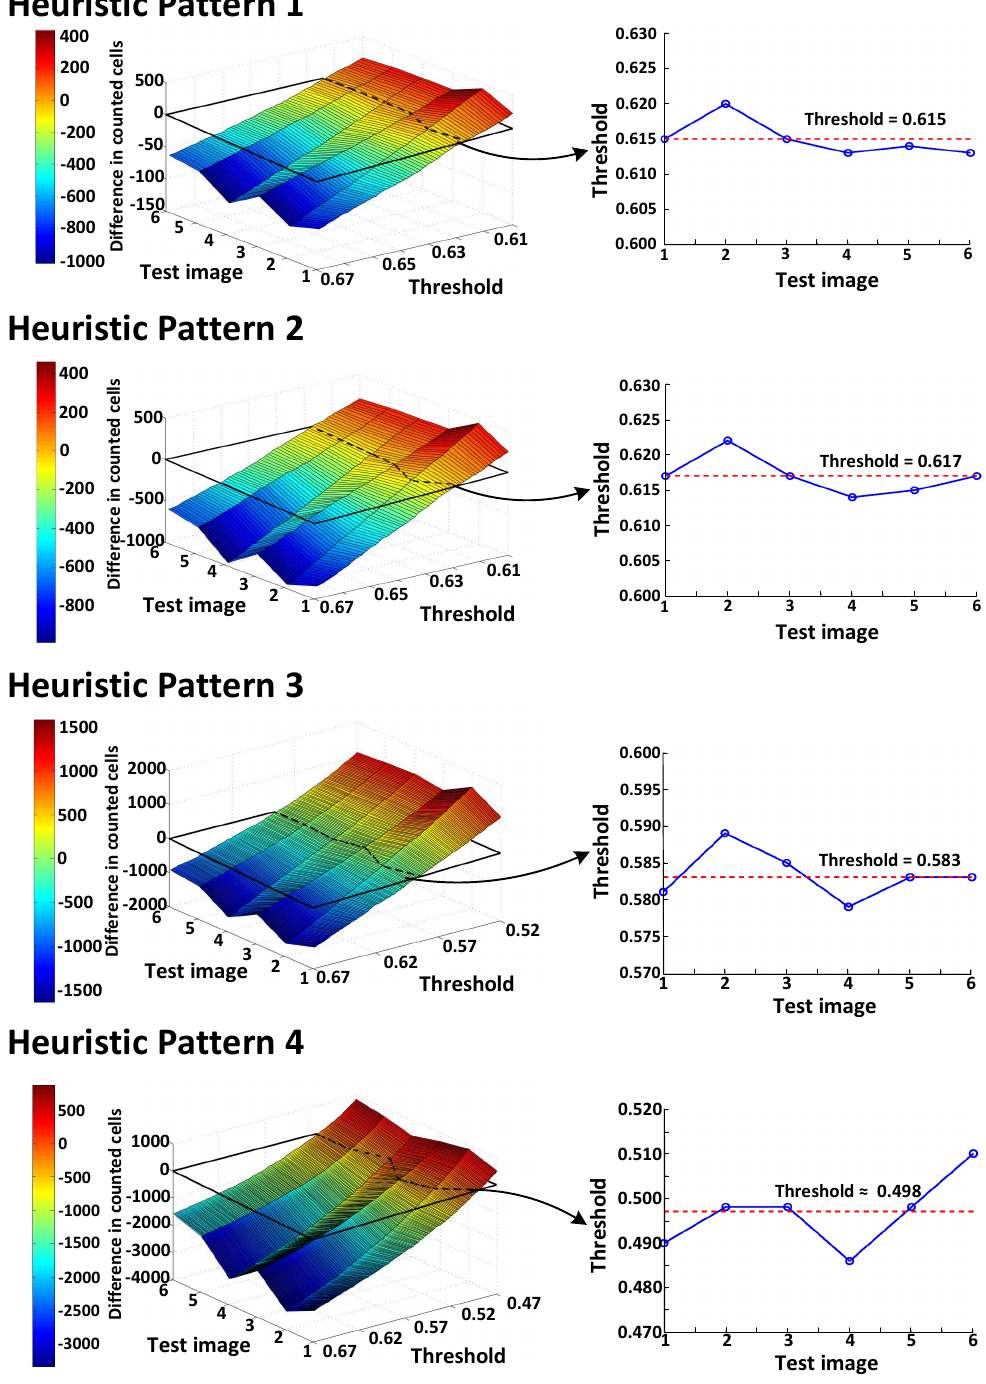
Figure 5. The difference in counted cells between the original algorithm and the algorithm with NCC approximation (heuristic Patterns 1 ∼ 4). The closer the difference is to zero, the more accurate the algorithm with NCC approximation gets. Since all four heuristic patterns for NCC approximation cross zero, it is possible to find the best threshold values that can practically eliminate the accuracy loss, which are 0.615, 0.617, 0.583 and 0.498 for heuristic Patterns 1, 2, 3 and 4, respectively. The heuristic patterns 1 and 2 satisfy the accuracy requirement ( i.e ., zero loss) for the range of threshold ( > 0.6) and reduces the runtime required for NCC by